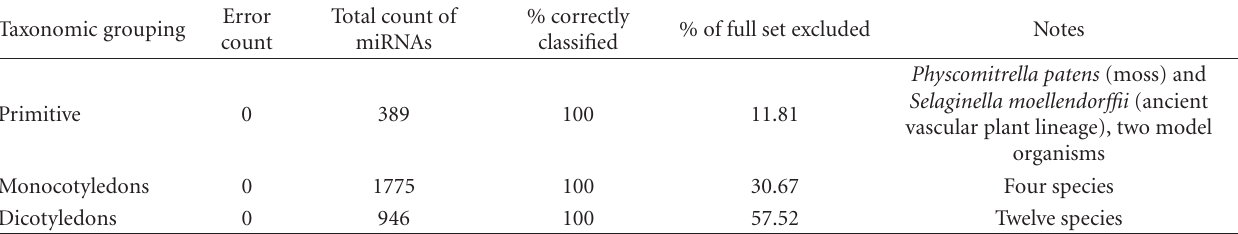
Table 9: Results from exclusion of each of the 3 taxonomic